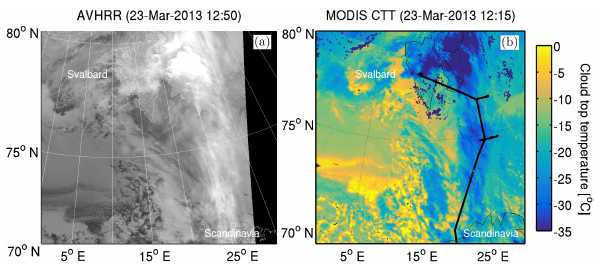
Figure 4. AVHRR visible satellite image (a) and cloud top temper- ature (CTT) derived from MODIS retrievals (b) at times close to the start of section 2 of B762. Section 2 of the flight track is indicated (black) in (b)